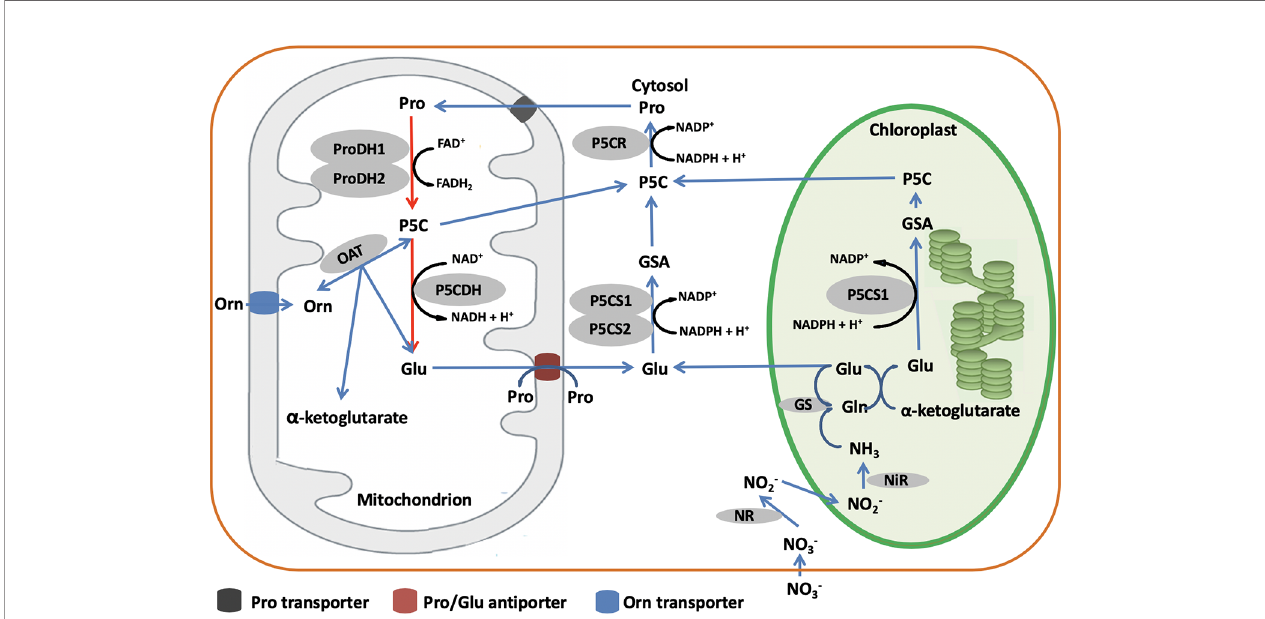
FIGURE 3 | Proposed proline metabolism pathways in higher plants. Biosynthesis (blue lines) and catabolism (red lines) are shown. Abbreviations: Pro, proline; Glu, glutamate; Orn, ornithine; NR, nitrate reductase; NiR, nitrite